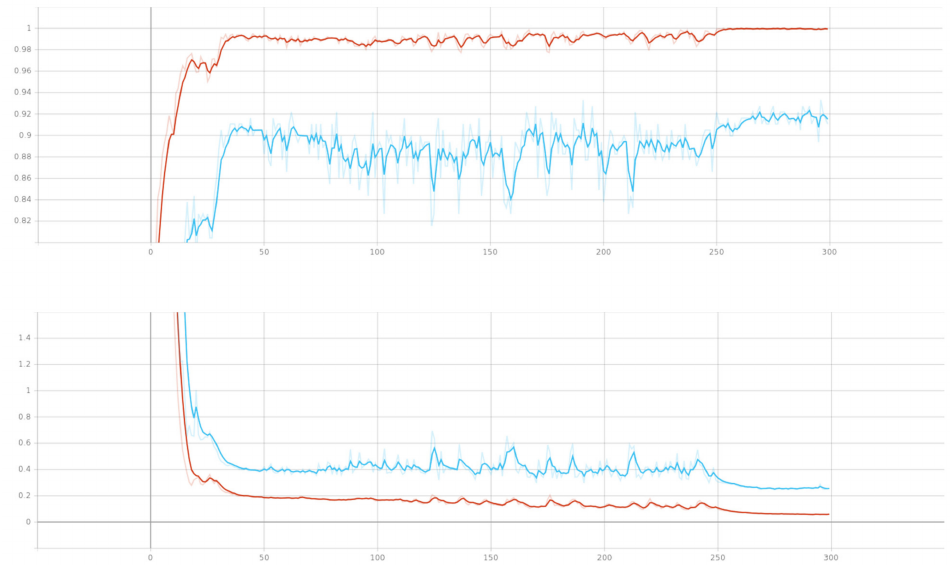
Figure 11. Training curves of accuracy and loss against number of epochs (red: training set; blue: validation